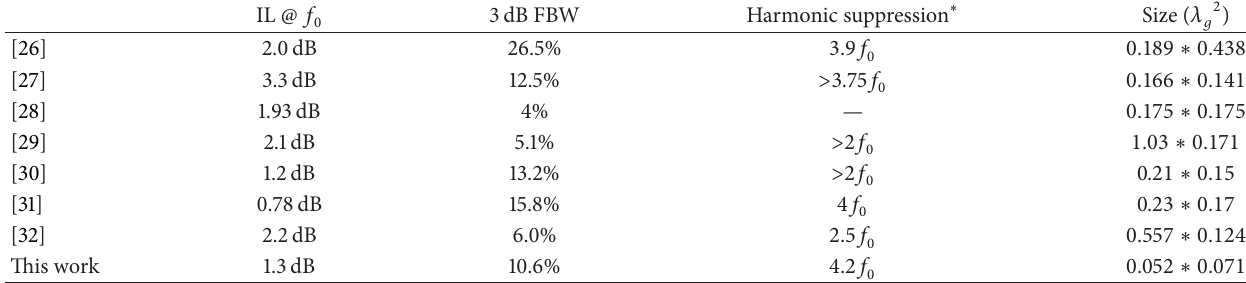
Table 2: Comparison with some previously published